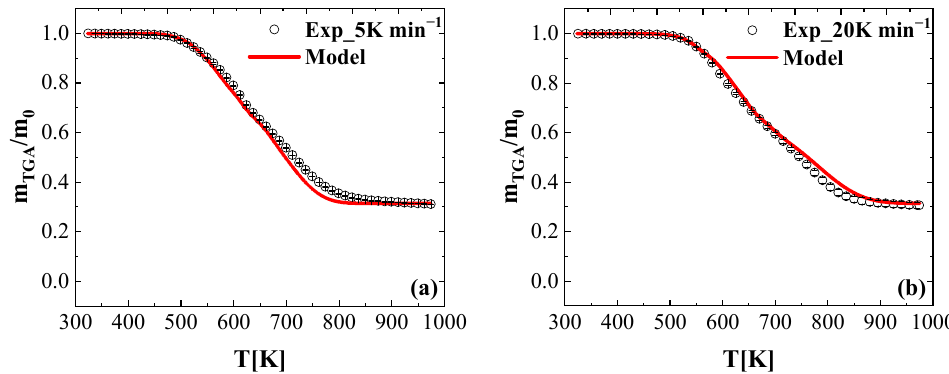
Figure 9. Experimental and simulated TGA data collected in nitrogen at a heating rate of ( a ) 5 K min − 1 and ( b ) 20 K min − 1 presented as normalized total mass.